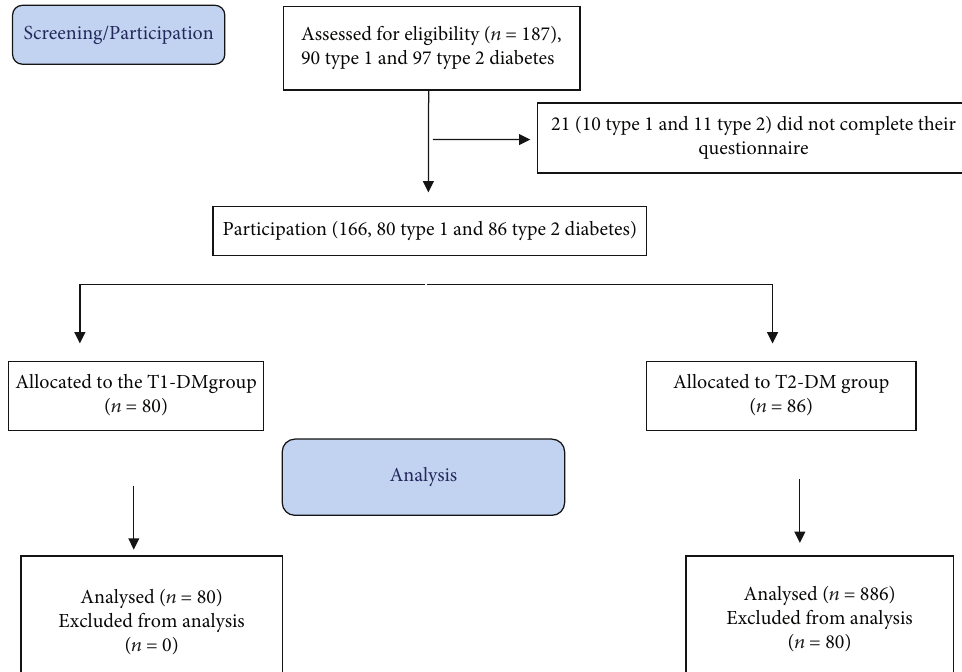
Figure 1: The CONSORT fl ow diagram of the study.